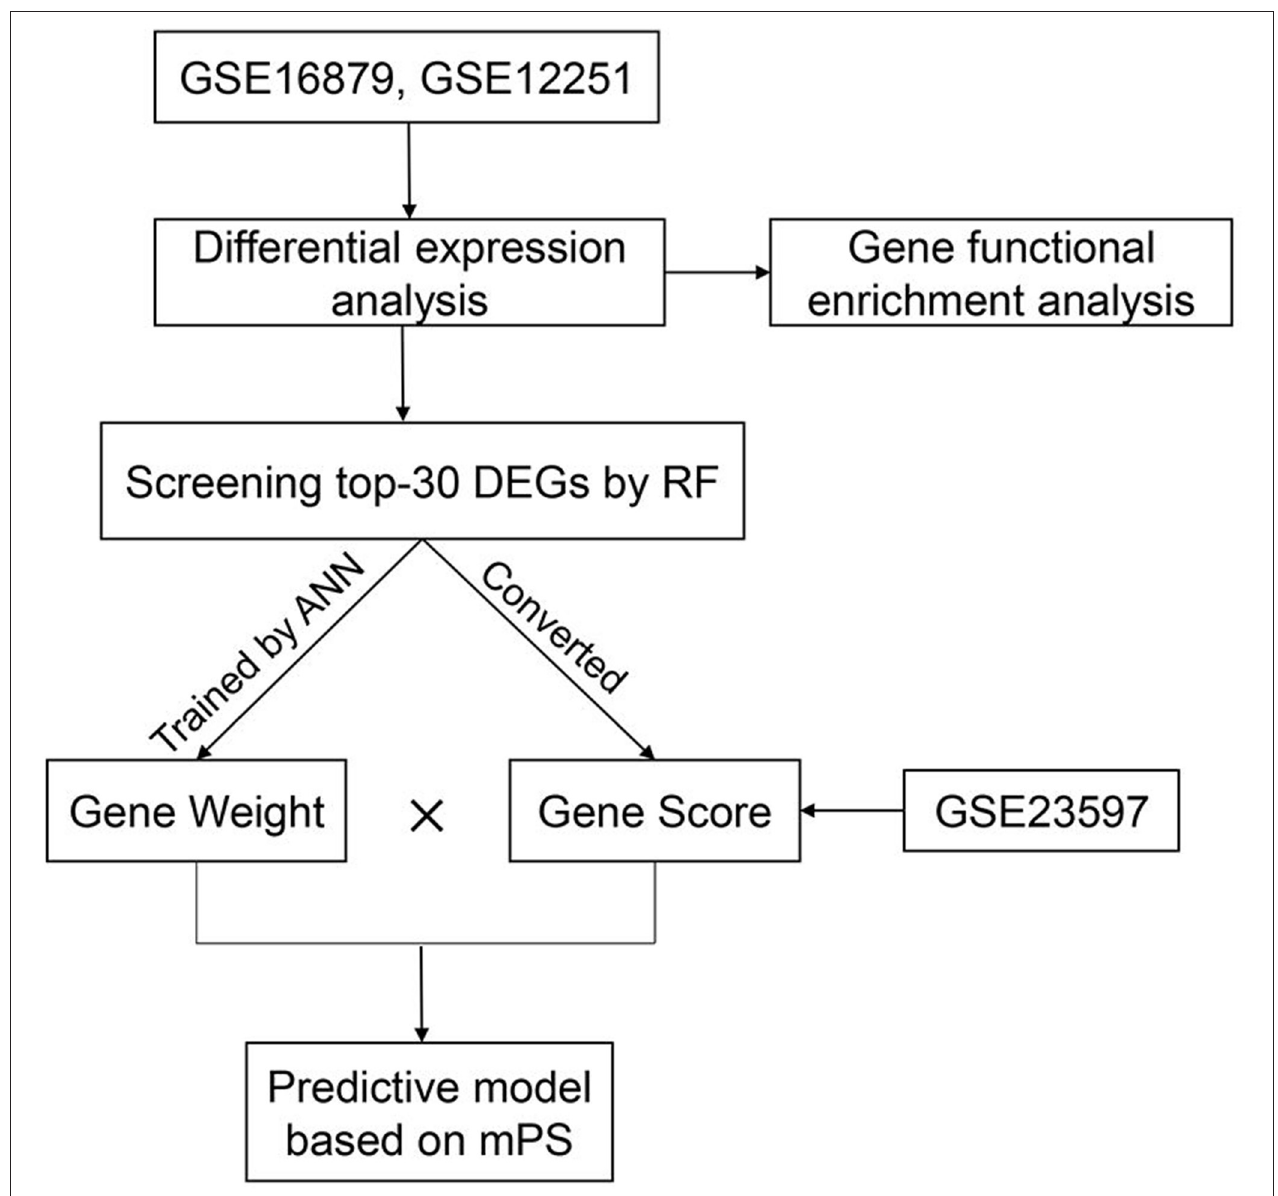
FIGURE 1 | The study